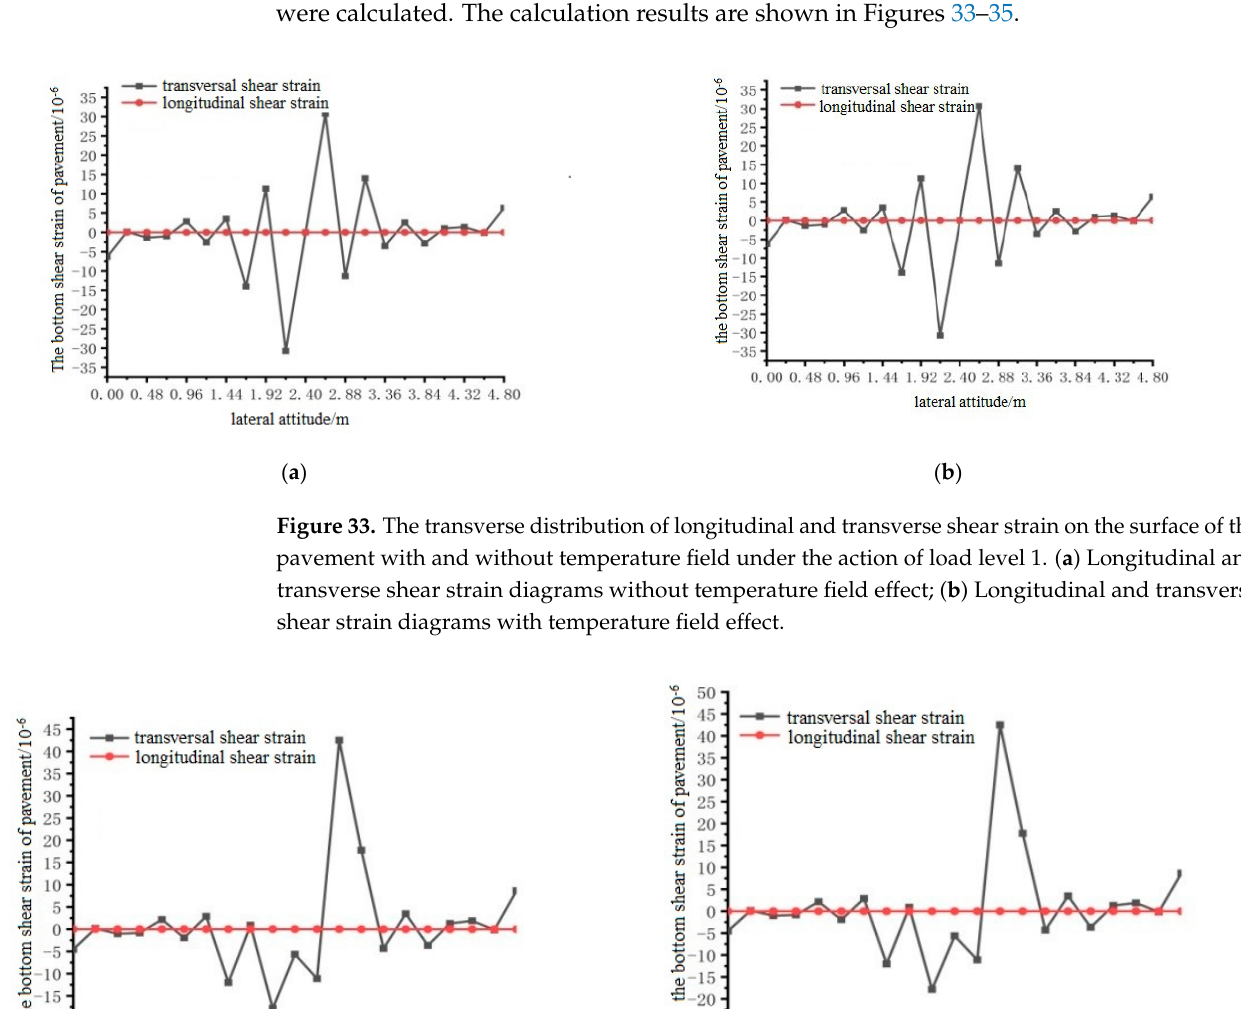
( b ) Figure 35. The transverse distribution of longitudinal and transverse shear strain on the surface of the pavement with and without temperature field under the action of load level 3. ( a ) Longitudinal and transverse shear strain diagrams without temperature field effect; ( b ) Longitudinal and trans- verse shear strain diagrams with temperature field effect. It can be seen from the results shown in Figures 33–35 that the longitudinal shear strain at the bottom of the pavement layer with and without the temperature field was far smaller than the transverse shear strain. The effect of the temperature field made the trans-